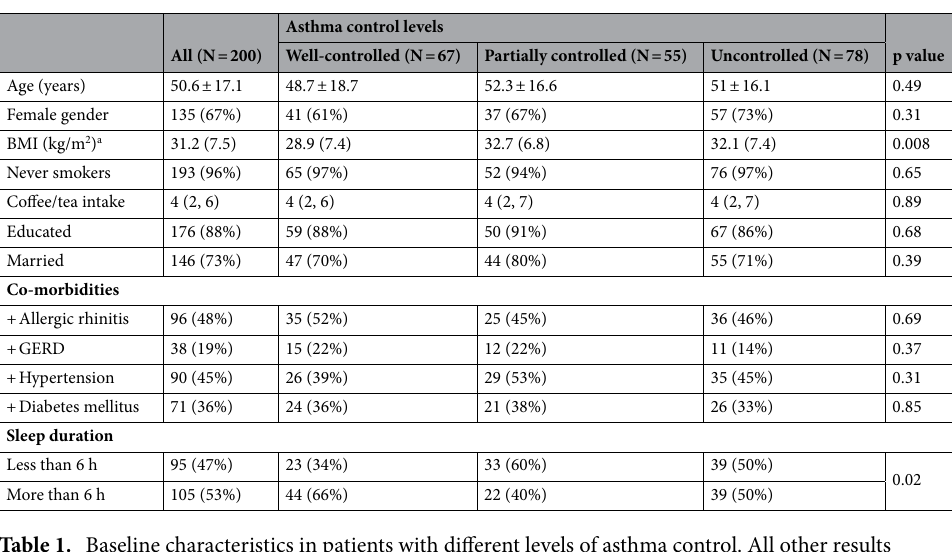
Table 1. Baseline characteristics in patients with different levels of asthma control. All other results are reported as means ± standard deviations or frequencies (percentages). BMI body mass index, GERD gastroesophageal reflux disease. a Reported as median (IQR).